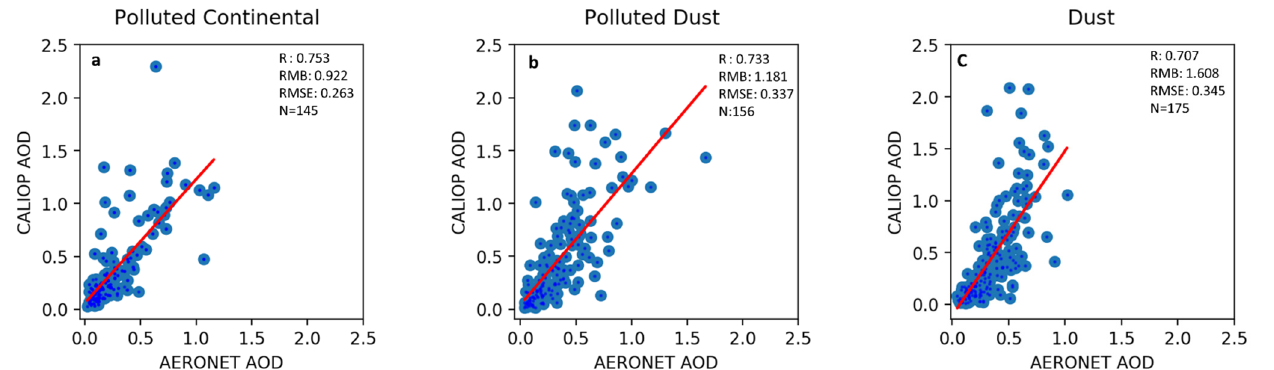
Figure 4. Scatterplot of CALIOP AOD vs. AERONET AOD for different aerosol types: ( a ) polluted continental (PC/S), ( b ) polluted dust (PD), and ( c ) dust (DD). The red lines are the linear regressions. The performance measures are the Pearson’s correlation coefficient ( r ), RMSE, and relative mean bias (RMB).